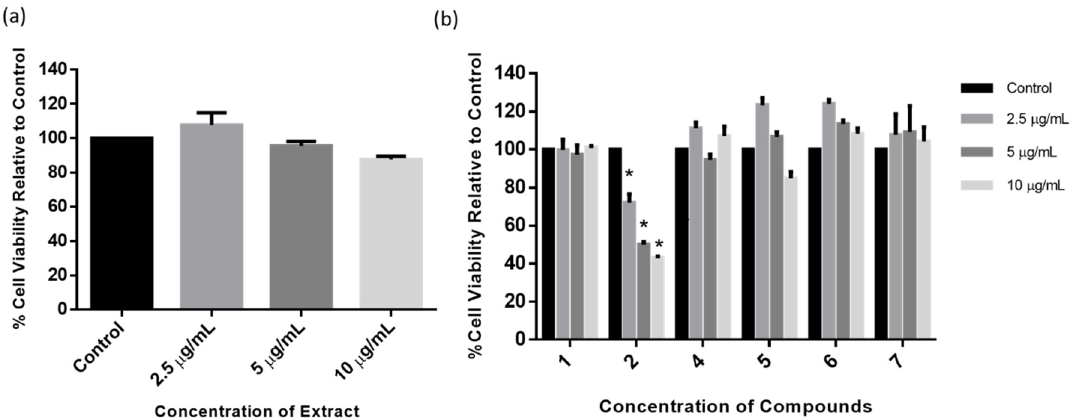
Figure 4. Dose–response of BHE and compounds. MTT assay cytotoxicity on SH-SY5Y cells treated with increasing concentrations (2.5, 5, and 10 µg/mL) of ( a ) BHE and ( b ) compounds for 24 h, and each bar represents mean cell viability expressed as percentage of control; * indicates significance at p < 0.05.